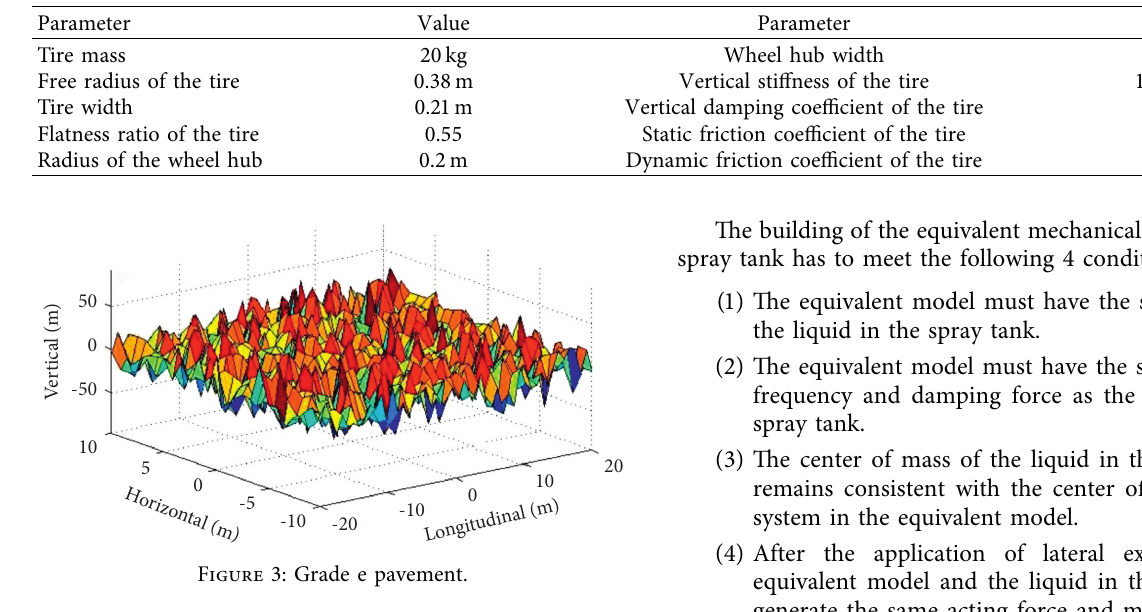
Table 2: Tire model parameters.